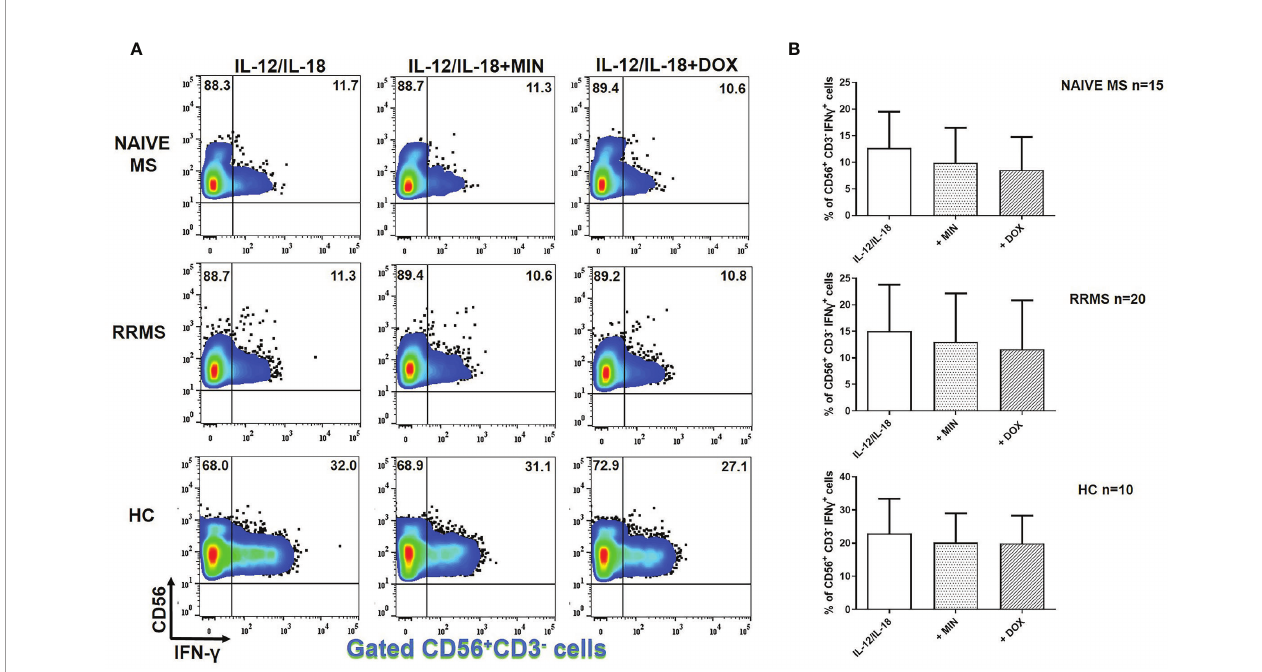
FIGURE 4 | Tetracyclines have no signi fi cant effect on IFN- g + NK cells. PBMCs from naïve MS patients (n=15), RRMS patients (n=20) and HCs (n=10) were seeded in cell culture plates (1 x 10 6 per well) and stimulated with IL-12 plus IL-18 (IL-12/IL-18), IL-12/IL-18 plus minocycline (MIN) and IL-12/IL-18 plus doxycycline (DOX) for 5h. Cells were collected, washed, surface stained with appropriate monoclonal antibodies an analyzed for intracellular IFN- g production by fl ow cytometry (see also methods section). Individual cell subsets were sub-gated according to expression of CD3 and CD56 surface epitopes. (A) Flow cytometry dot-plots showing the frequency of CD56 + CD3 - IFN g + NK cells (gated CD56 + CD3 - cells two-dimensionally depicted in CD56 vs IFN- g plots) in IL-12/IL-18, IL-12/IL-18/MIN and IL-12/IL-18/ DOX treated cells from representative MS cases. (B) Box and whiskers graphical representation show no signi fi cant reduction in the percentages of IFN- g -producing NK cells in the presence of tetracyclines in either HCs or MS